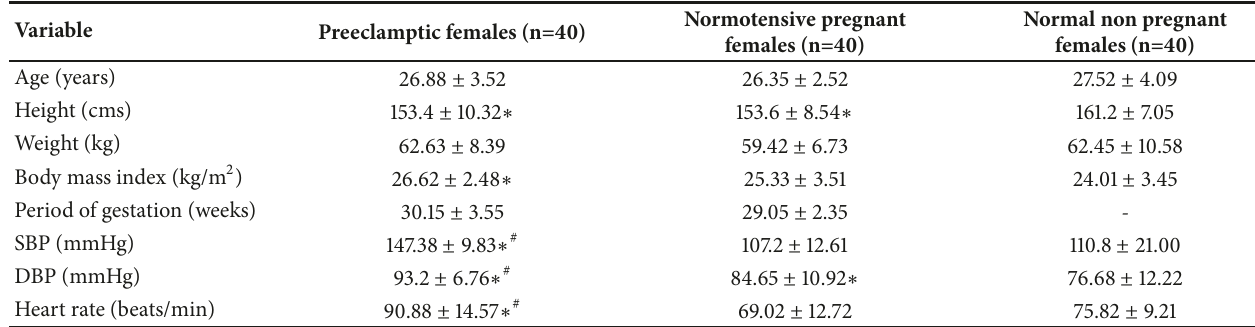
Table 1: Comparison of baseline characteristics in different groups.